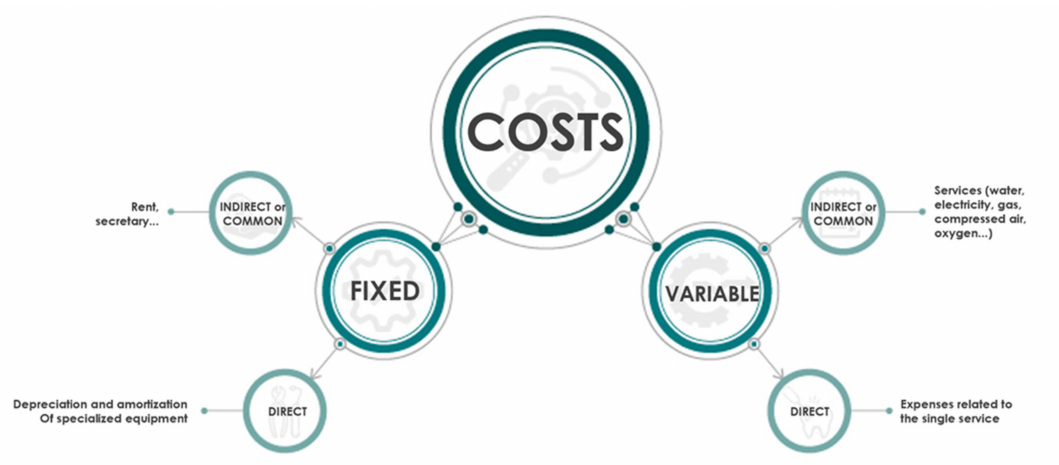
Figure A1. Classification and description of the main costs in a dental